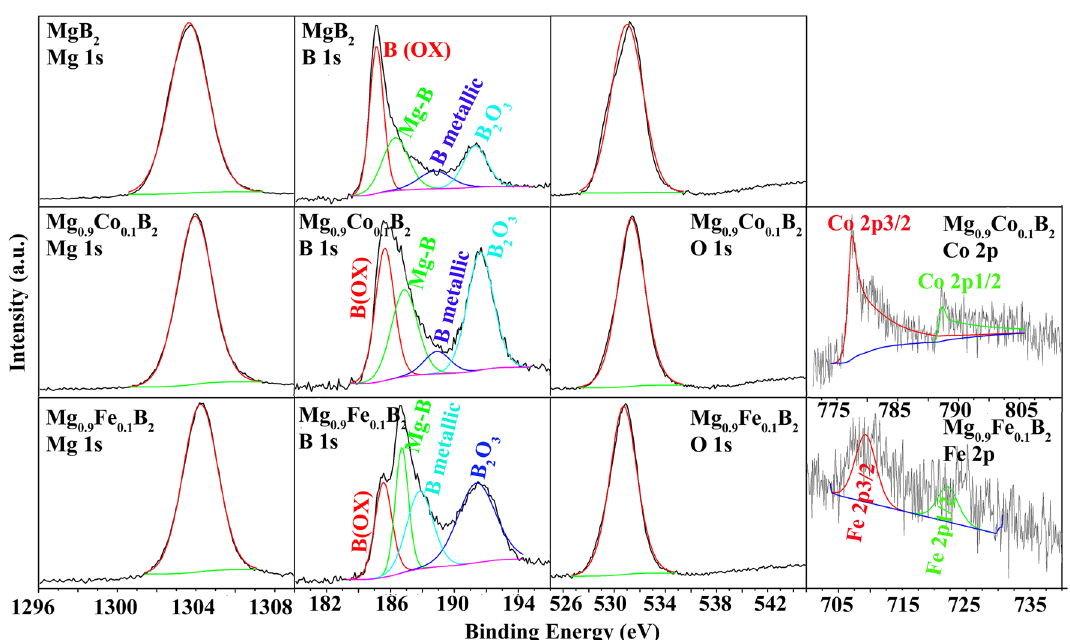
Figure 3. XPS spectra of Mg 1s, B 1s, O 1s, Co 2p, and Fe 2p in MgB 2 , Mg 0.9 Co 0.1 B 2 , and Mg 0.9 Fe 0.1 B 2